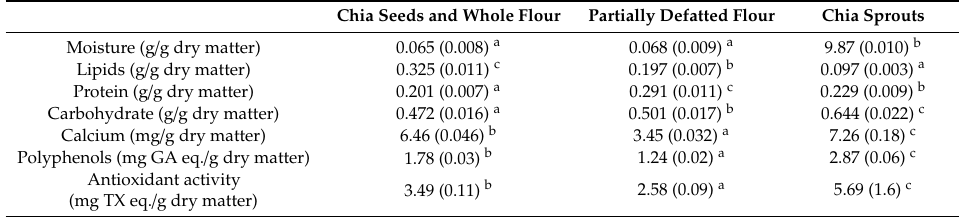
Table 2. Nutritional composition of chia seeds and whole flour, partially defatted chia flour and sprouts (data are expressed as mean (SD) from three